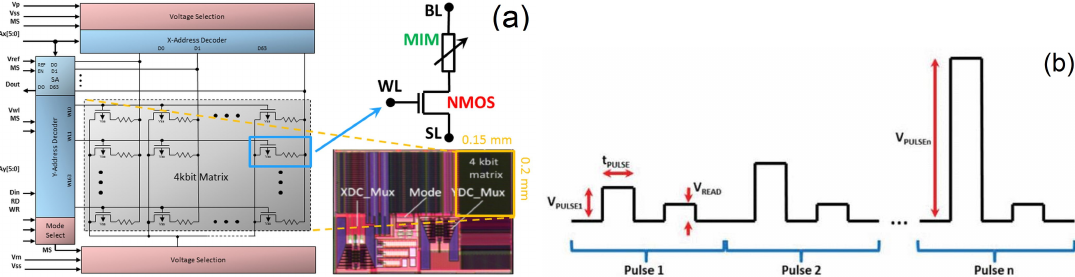
Figure 1. Micrograph and block diagram of the 4 kbit memory chip and schematic of the 1-transistor-1-resistor (1T1R) cells integrated into the array ( a ) [17]. Schematic illustration of the voltage waveform of the incremental step pulse with verify algorithm (ISPVA) ( b )